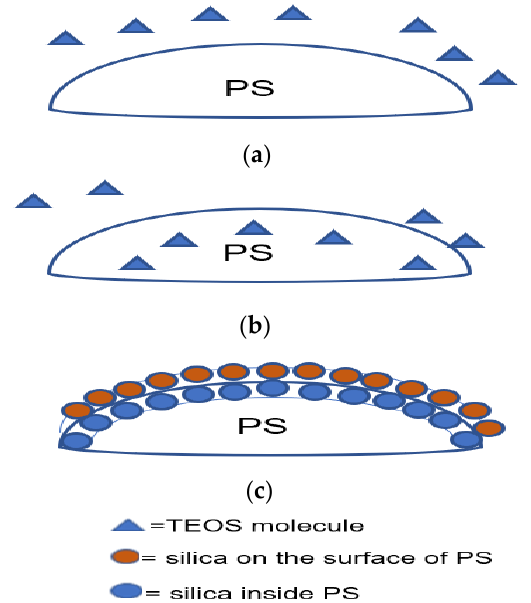
Figure 20. Schematic of the formation of silica on PS with the aid of supercritical CO 2 . ( a ) PS and TEOS before supercritical CO 2 treatment, ( b ) penetration of TEOS inside PS after immersion in supercritical CO 2 , and ( c ) formation of the shell of silica inside and outside PS after the sol–gel reaction. Similarly, G. Sun et al. [88] successfully used two types of crosslinked PS ( PS-EGDMA and PS-DVB ( divinylbenzene )) that were treated with supercritical CO 2 to produce hollow silica. Crosslinked PS-EGDMA and PS-DVB with an average diameter of 220 and 400 nm were treated with TEOS in a stainless-steel autoclave at different pressures with super- critical CO 2 . After depressurisation, the treated PS was coated with a sol–gel reaction with ammonium hydroxide as a catalyst. Coated PS-EGDMA (240 nm external diameter) and PS-DVB (420 nm external diameter) produced hollow silica spheres with a 20 nm and 24 nm shell thickness, respectively. Similar to Z. Chen et al. [108], trapped TEOS was suggested to contribute to the shell formation. The diffusion rate of trapped TEOS to the PS surface and reaction kinetics in solution was proposed to determine the shell